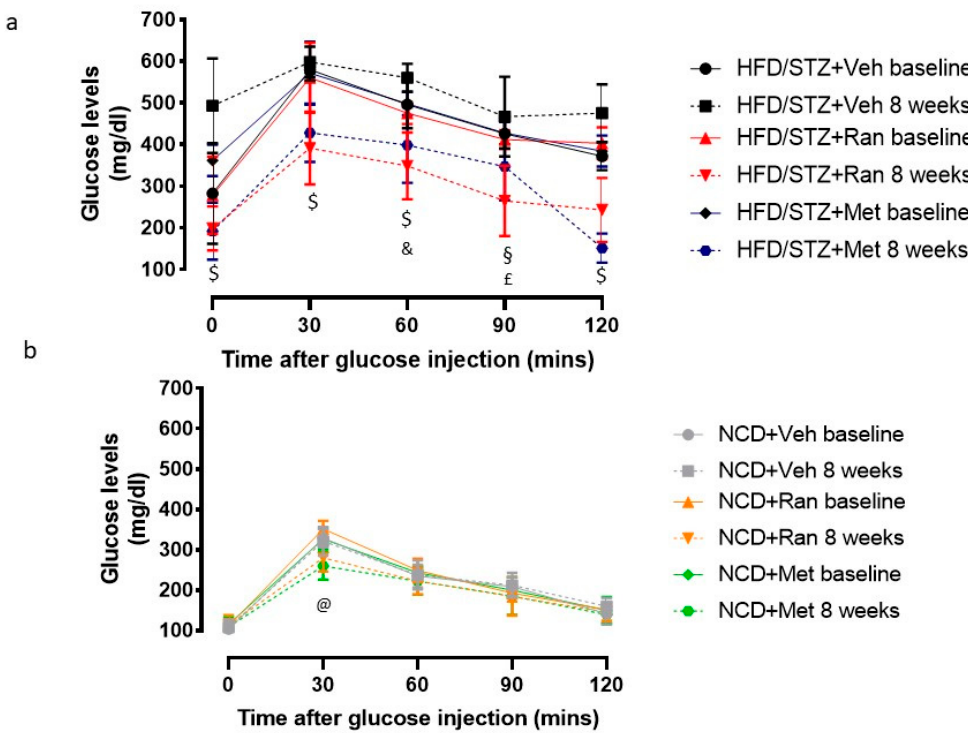
Figure 1. Blood glucose levels (mg / dl) during the intraperitoneal glucose tolerance test (IPGTT) at baseline (after induction of diabetes) and after 8 weeks of treatment in diabetic ( a ) and normal caloric diet (NCD) ( b ) rats. Values are means ± SD. $ p < 0.0001 HFD / STZ + Ranolazine and HFD / STZ +